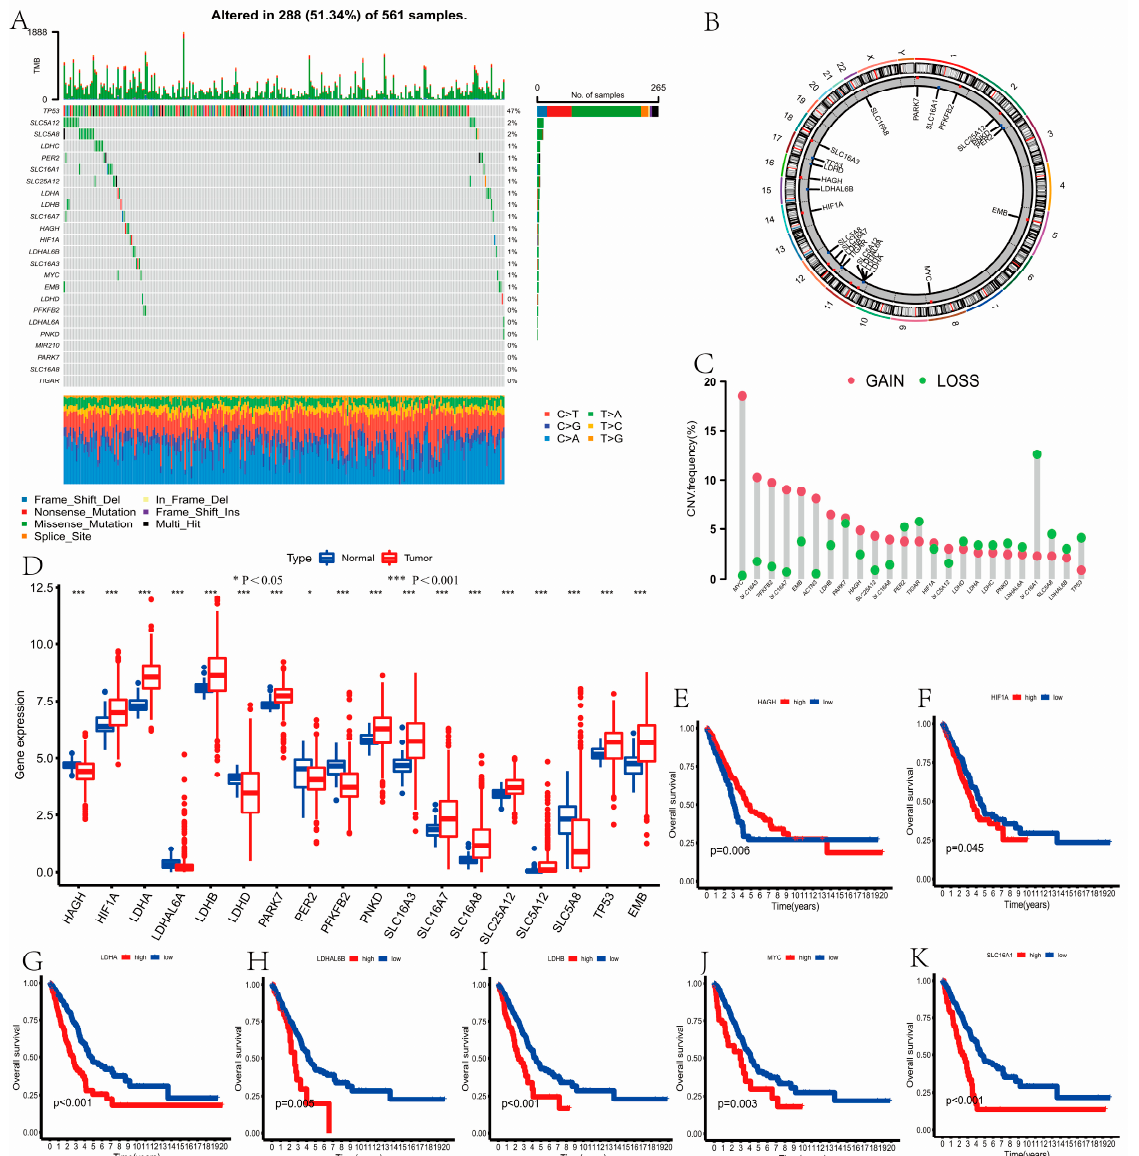
Figure 1. Mutation, CNV, expression and survival of lactate-related genes (LRGs) in lung adenocarcinoma (LUAD). ( A ) The mutation of LRGs in LUAD. ( B ) The locations of the CNV alterations in the LRGs. ( C ) The CNV alteration frequency of LRGs in LUAD. ( D ) The expression of LRGs between LUAD and normal samples. Comparing the normal samples, 18 LRGs were differentially expressed in tumor samples using the Wilcoxon test. ( E – K ) The high expression groups of HAGH had a better prognosis. The low expression groups of HIF1A, LDHA, LDHAL6B, LDHB, MYC, and SLC16A1 had a better prognosis using Kaplan–Meier method and log-rank test ( p < 0.05). * P < 0.05, *** P < 0.001.